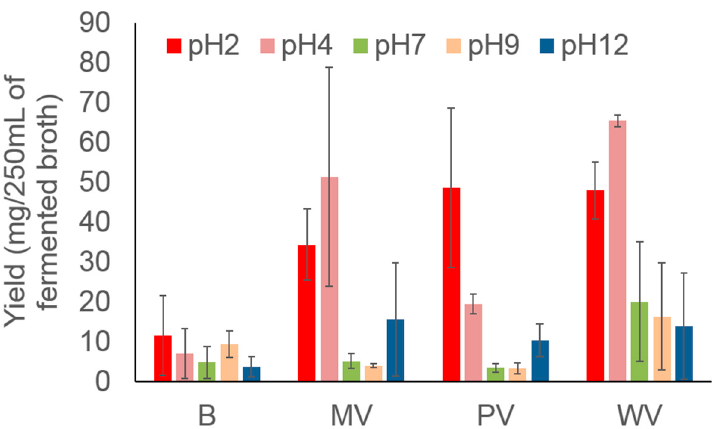
Figure 1. Yields of secondary metabolites extracted using the pH-variation method.